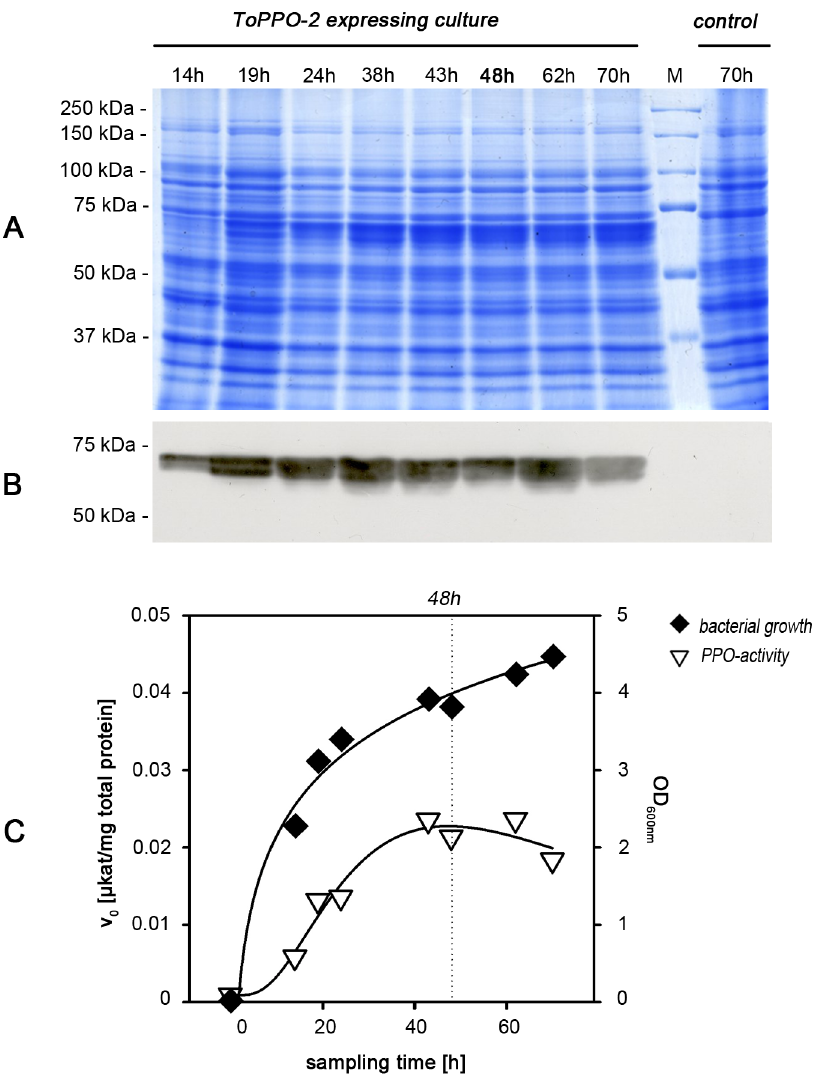
Figure 4. Optimal time for harvest of recombinant ToPPO-2. A SDS-PAGE of crude protein extracts. Samples were taken at different sampling times and analyzed by SDS-PAGE (same total protein amount per well). To visualize protein composition a Coomassie-staining was performed. B Western blot analysis. Proteins were blotted on a nitrocellulose membrane. Strep-Tactin-HRP conjugate was used to specifically detect the StrepII-tag of the recombinant PPO. C Bacterial growth and PPO-activity over sampling time. Samples were checked for their OD at 600 nm. Additionally crude protein extracts were analyzed for PPO-activity per mg of total protein. The presented data show one experiment representative for three replicates .